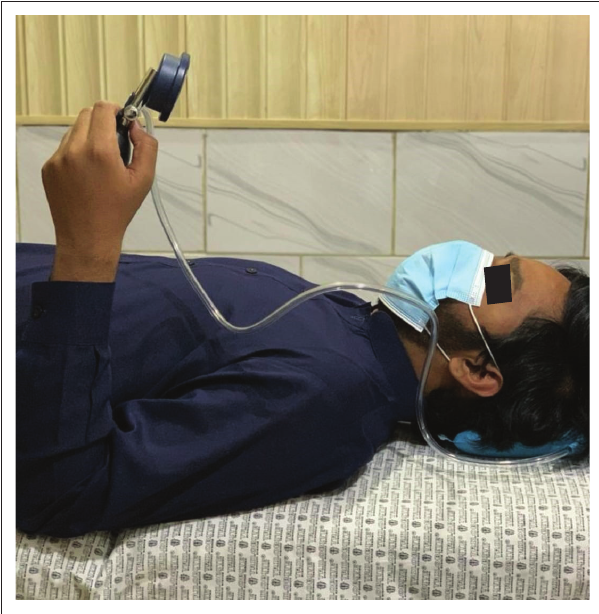
FIGURE 4: Measurement of the neck extensor strength with the handheld